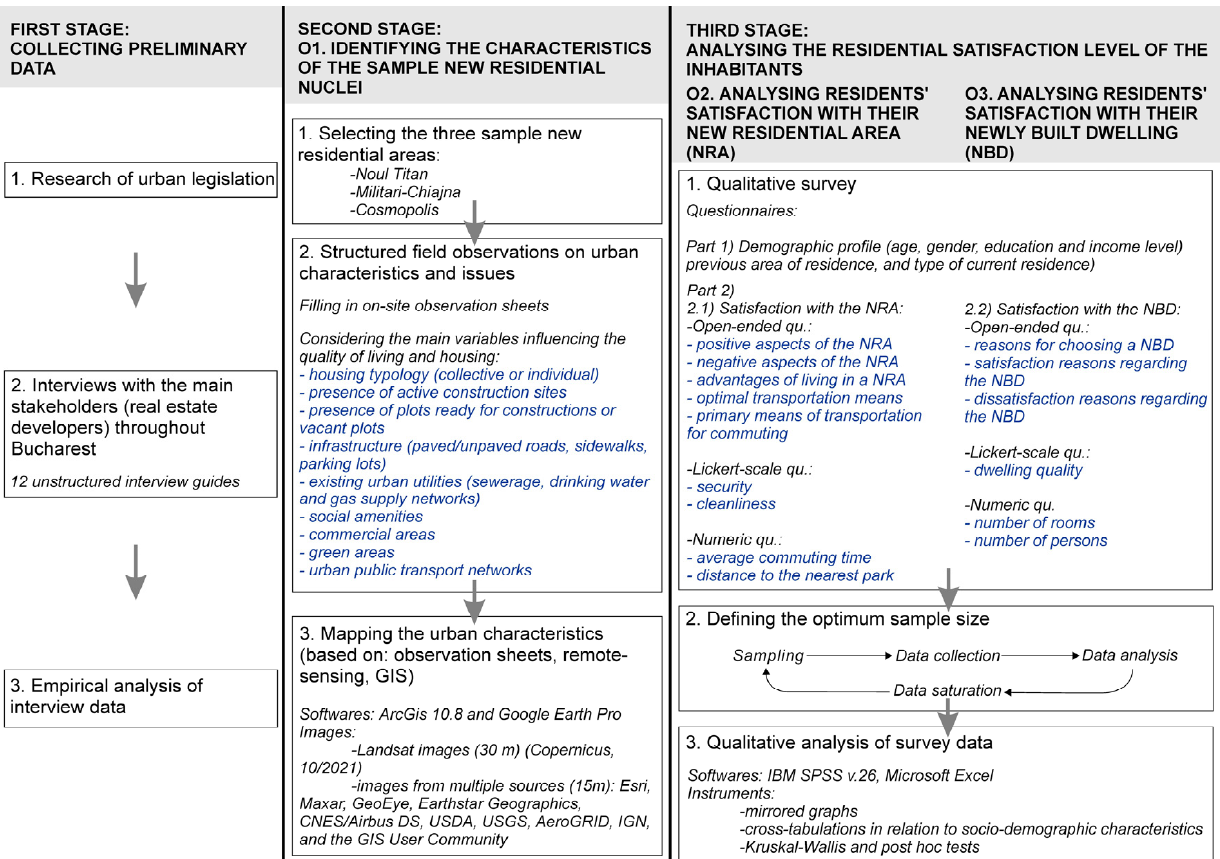
Figure 2. Methodological framework of the